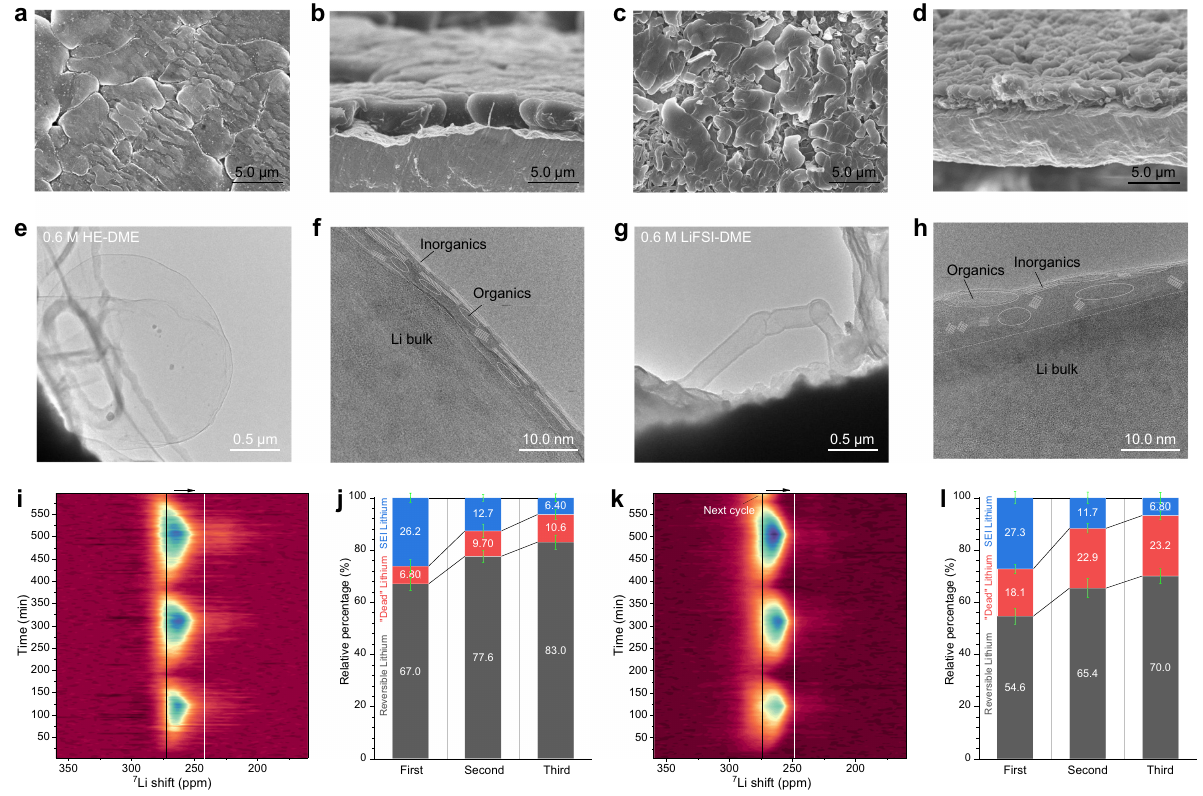
Fig. 3 | Morphology and microstructure of the lithium deposits. Lithium-metal morphology after plating a , b for the 0.6M HE-DME electrolyte; c , d for the 0.6M LiFSI-DMEelectrolyte. a , c Topview; b and d cross-sectionalview.Microstructureof deposited lithium metal and interfacial phase from cryo-TEM images e , f for the 0.6M HE-DME electrolyte; g , h for the 0.6M LiFSI-DME electrolyte. The enlarged images of f and h are shown in the Supplementary Figs. 46 and 47. Operando 7 Li solid-state NMR spectra and quanti fi cation of the lithium species, i , j for the 0.6M